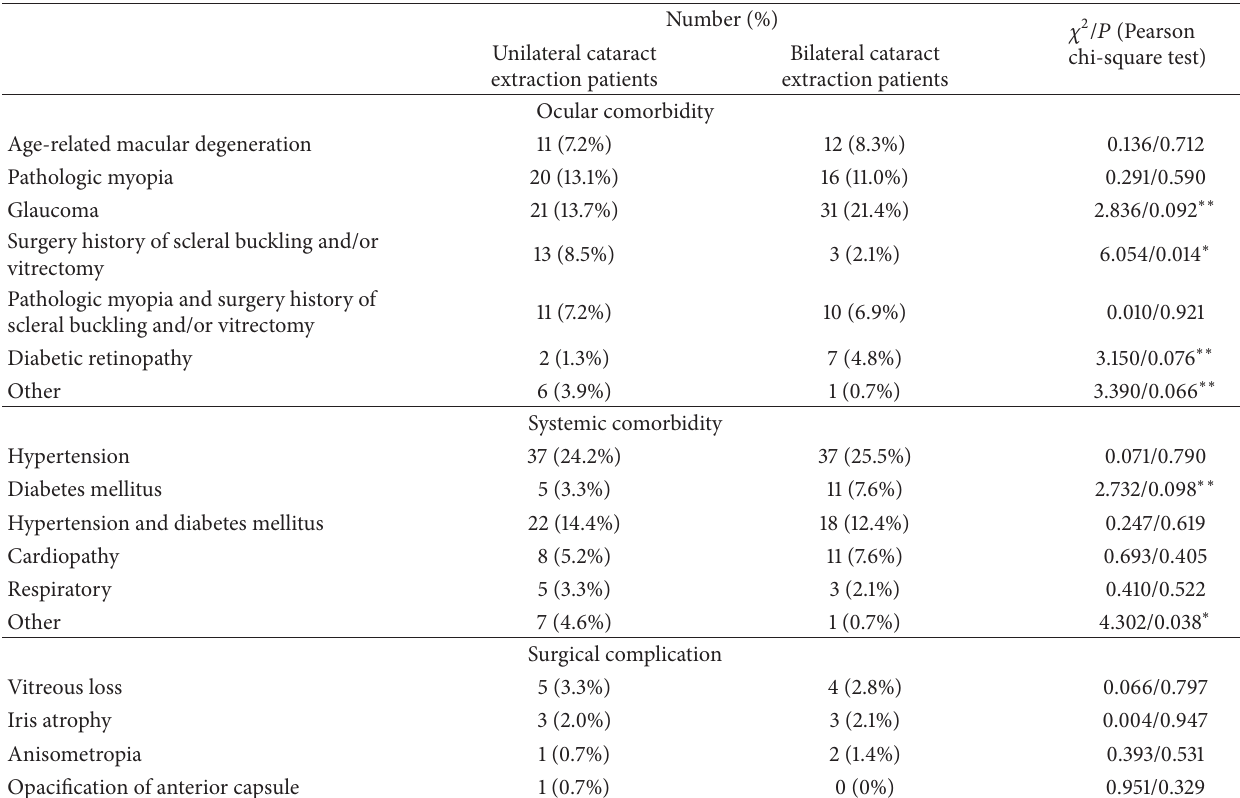
Table 2: Ocular comorbidities, systemic comorbidities, and surgical complications in patients receiving either unilateral or bilateral cataract extraction, ∗ 𝑃 < 0.05 and ∗∗ 0.05 < 𝑃 < 0.10